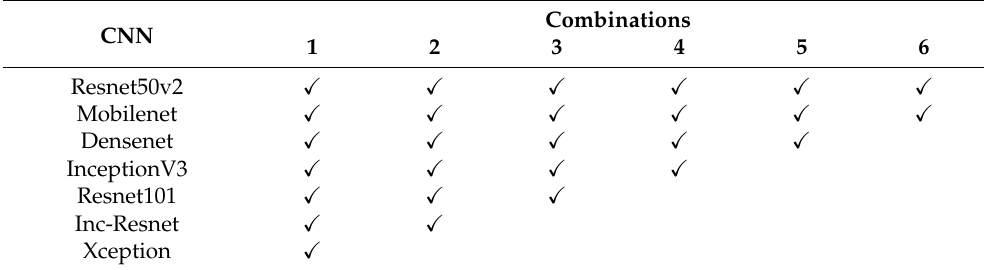
Table 3. Combinations of CNNs evaluated in the ensemble construction.